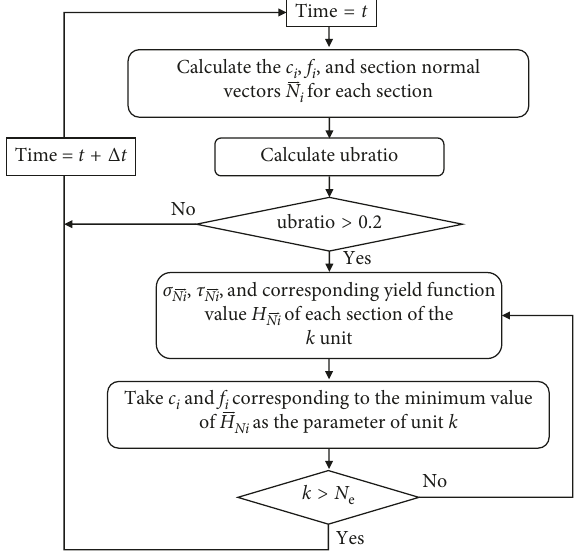
Figure 2: Program sketch of FLAC 3D using orthotropic yield criterion.